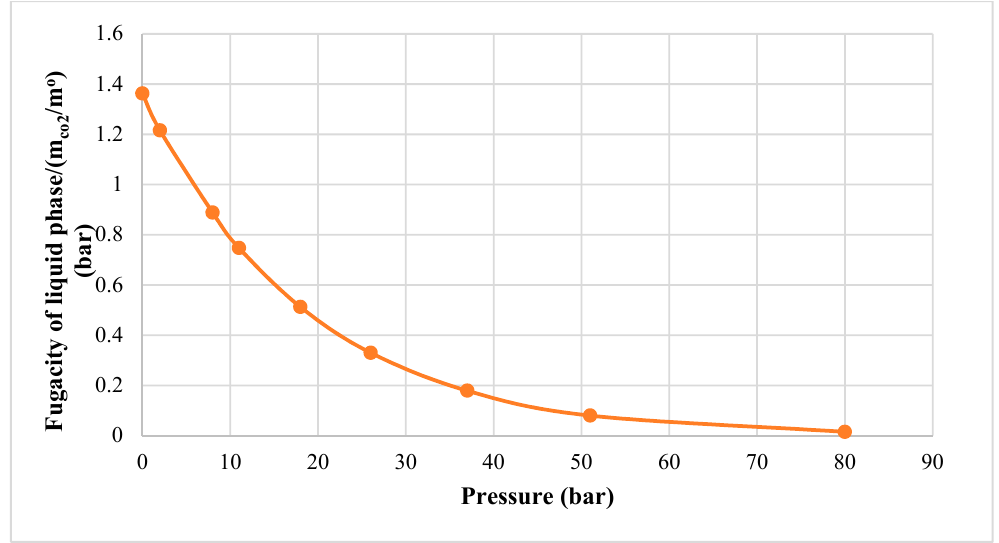
Figure 3. Ratio between the fugacity of carbon dioxide in the liquid phase and carbon dioxide solubility as a function of pressure for a real solution at 298.15.